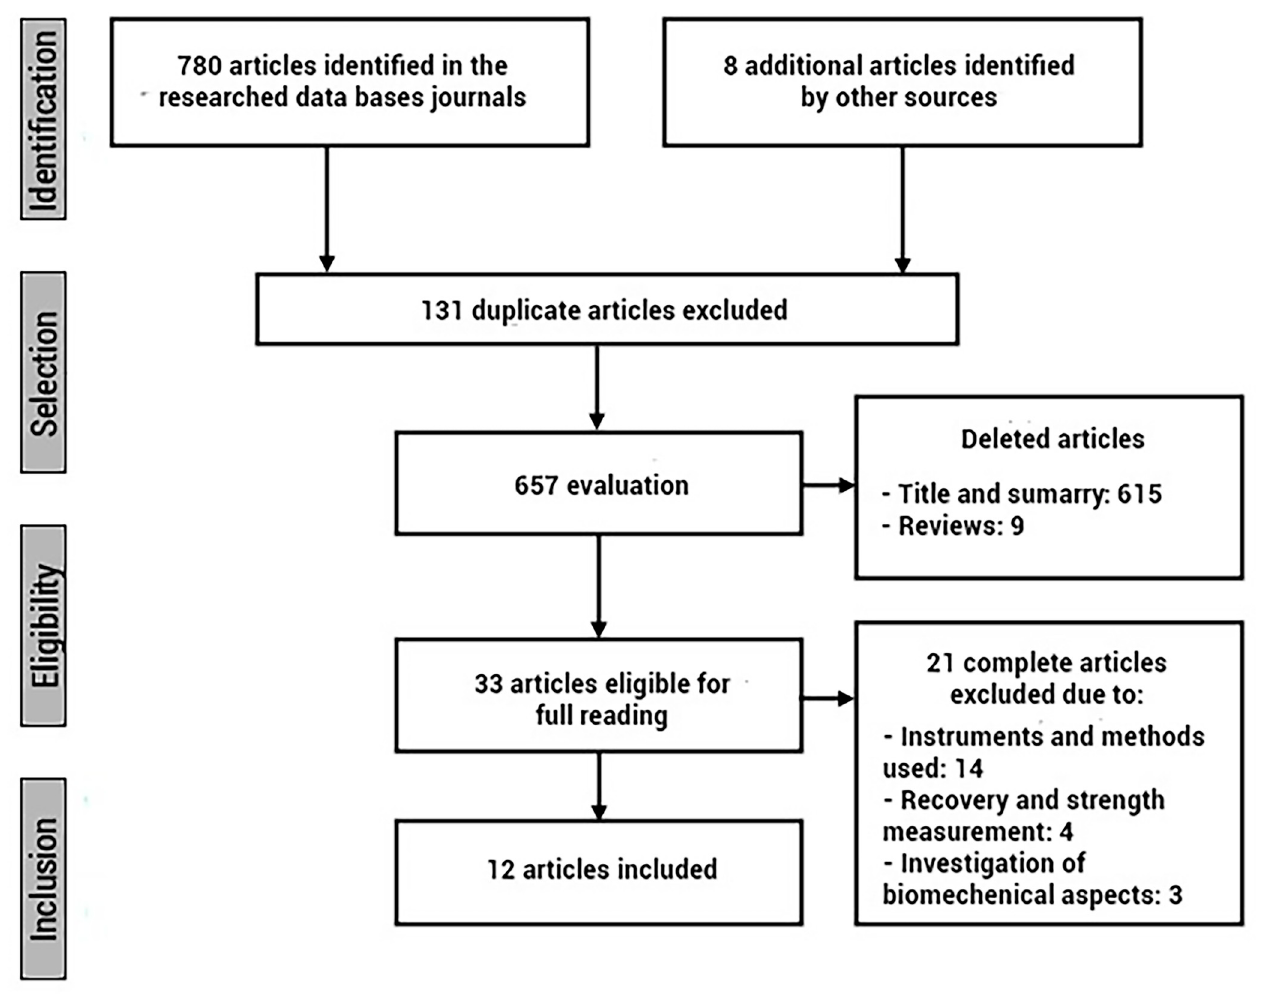
Fig 1. Flowchart of the review process.